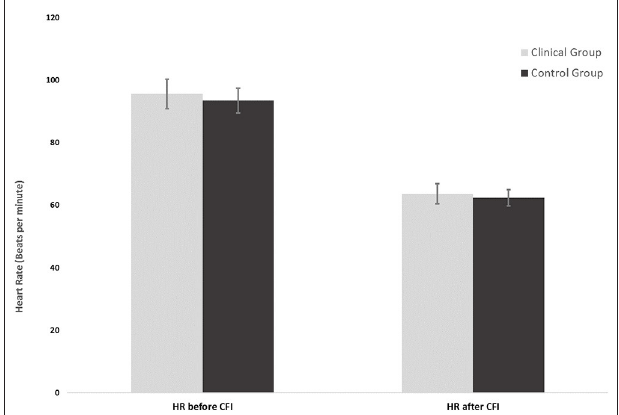
FIGURE 2 | Heart rates of the clinical group ( n = 16) and control group ( n = 16) at the start and end of the CFI task following CO 2 challenge.